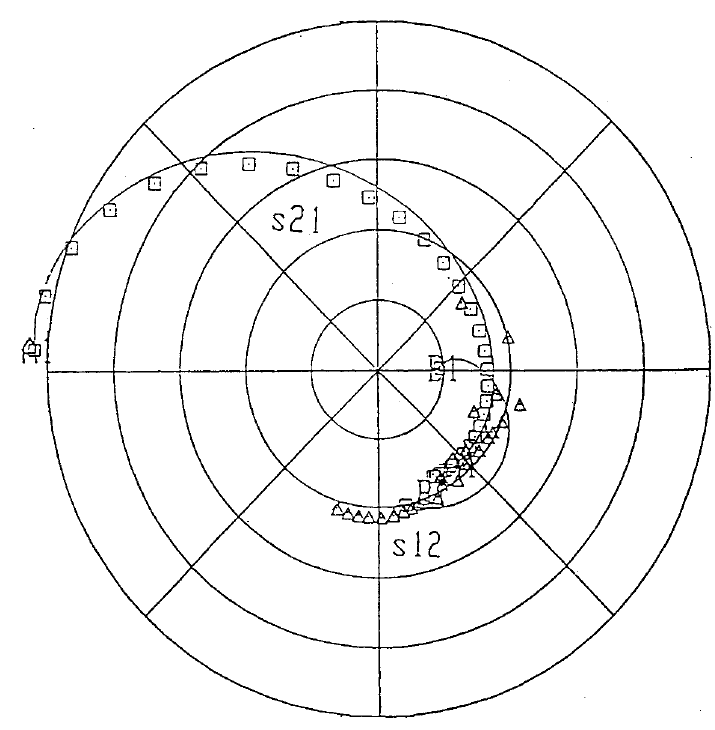
FIGURE 6 The measured and simulated S 21 , S 12 from 130MHz